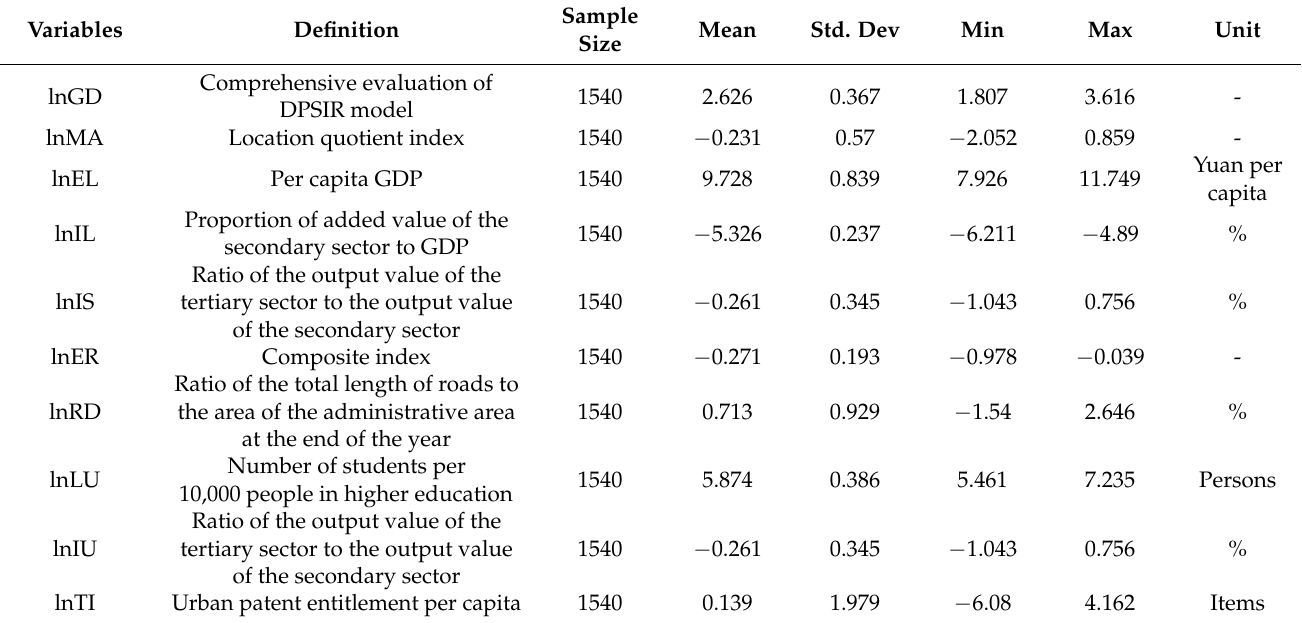
Table 1. Descriptive statistics of